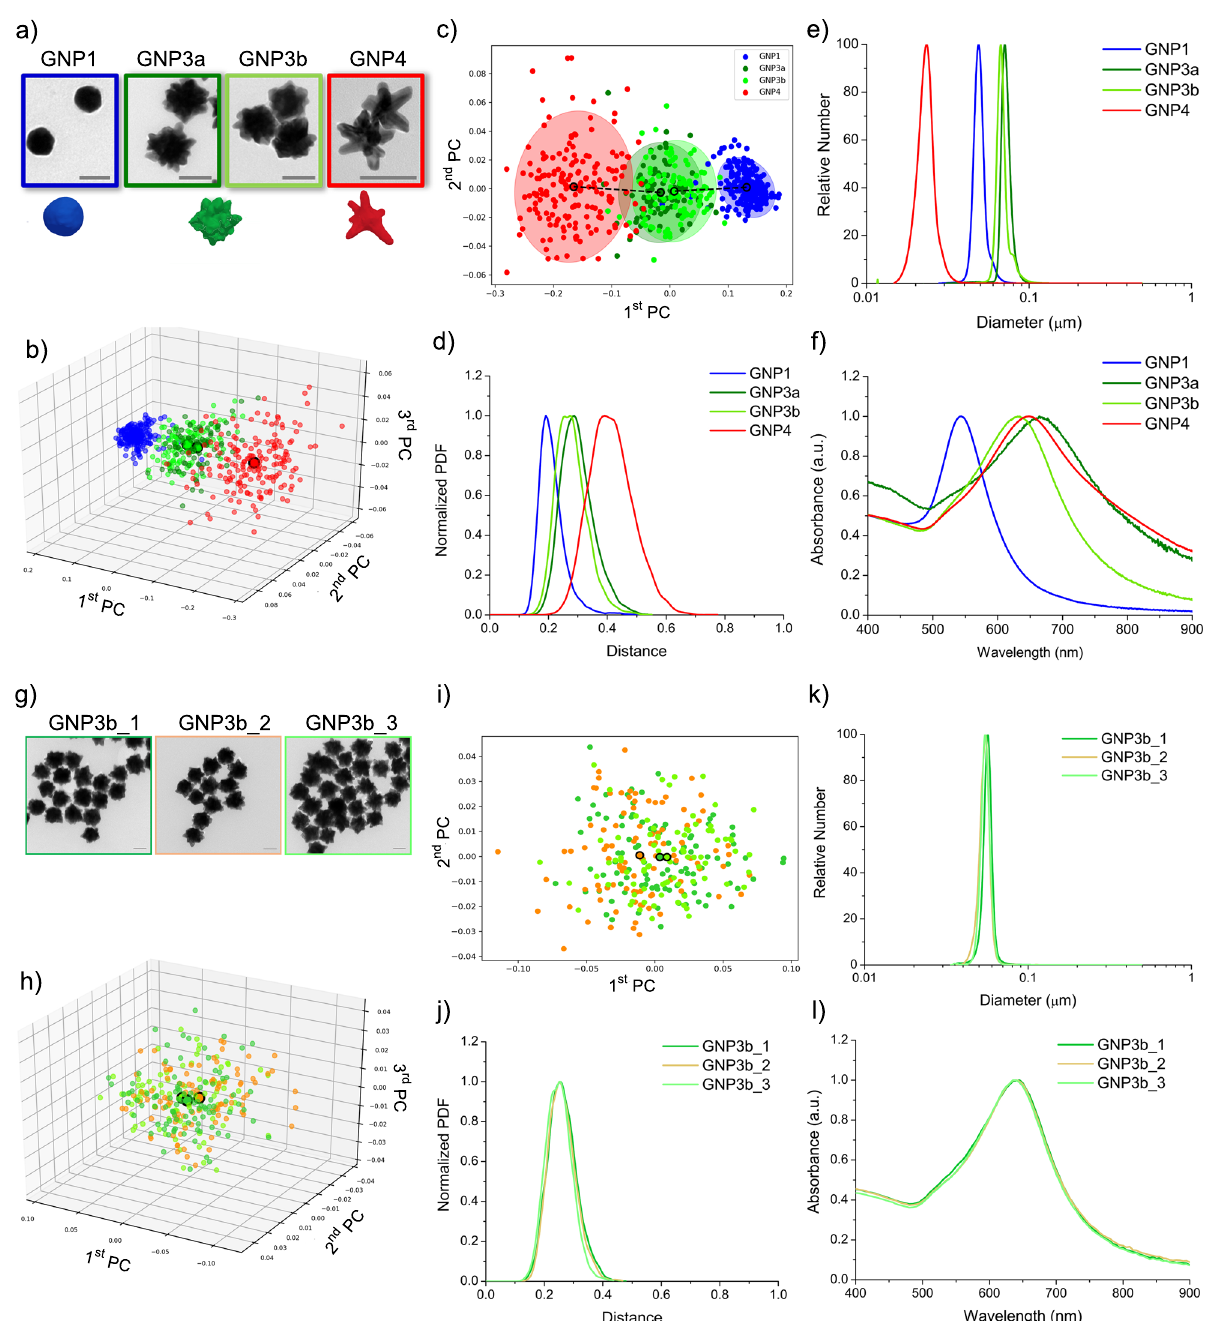
Fig. 3 Full characterization for the GNPs used in the biological study. a Representative TEM images and cartoon for GNP1, 3a, 3b, and 4 (scale bars are 50 nm). b 3D and c 2D scatter plot of the principal components, d intra-batch probability density distribution, e differential centrifugal sedimentation (DCS) analysis expressed as relative number, f normalized UV – Vis-IR absorption spectra. Qualitatively, GNP3a and GNP3b have 15 – 20 tips (GNP3a tip length = 15 – 25 nm, GNP3b tip length = 10 – 15 nm) while GNP4 have 3 – 5 tips (tip length = 15 – 25 nm). g Representative TEM images for three independent batches of GNP3b (scale bars are 50 nm), h 3D and i 2D scatter plot of the principal components, j intra-batch probability density distribution, k DCS analysis expressed as relative number, and l normalized UV – Vis – IR absorption